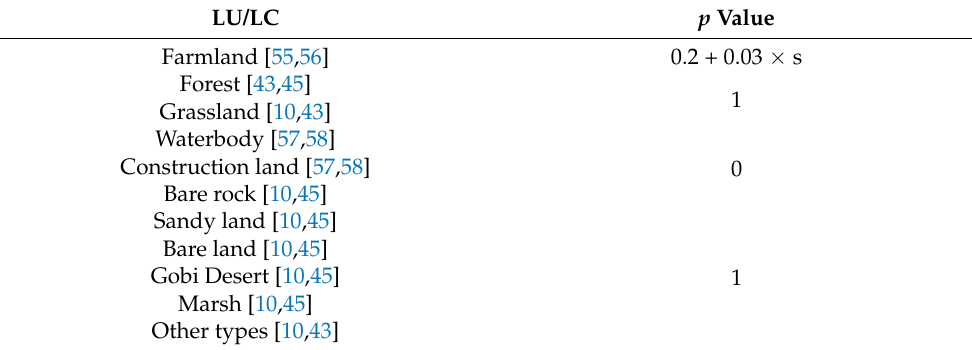
Table 1. The p factor estimation of various LU/LC in the YRB. LU/LC p